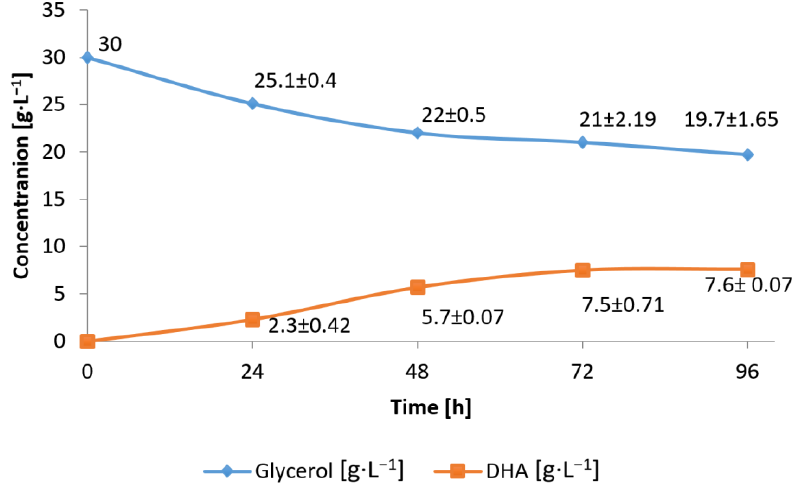
Figure 7. Time profiles of glycerol conversion and DHA formation during bioconversion of 30 g · L − 1 of a waste glycerol fraction with an immobilized cell extract obtained from G. oxydans